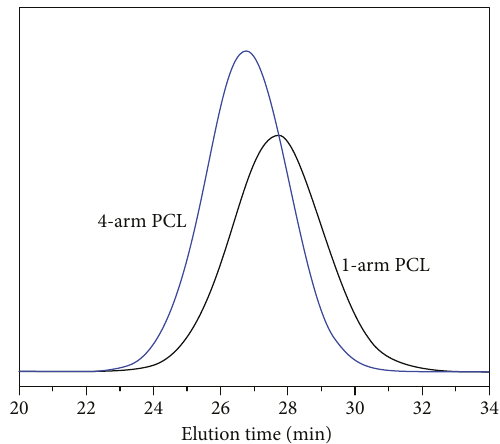
Figure 1: GPC curves of 4-arm PCL (blue) and 1-PCL